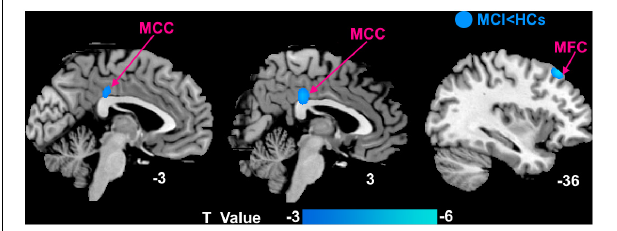
FIGURE 2 | Voxel-wise comparison of DC between patients with MCI and HCs with the age, education, and gender as covariates. MCI, mild cognitive impairment; HCs, healthy controls; MFC, middle frontal cortex; MCC, middle cingulate cortex.